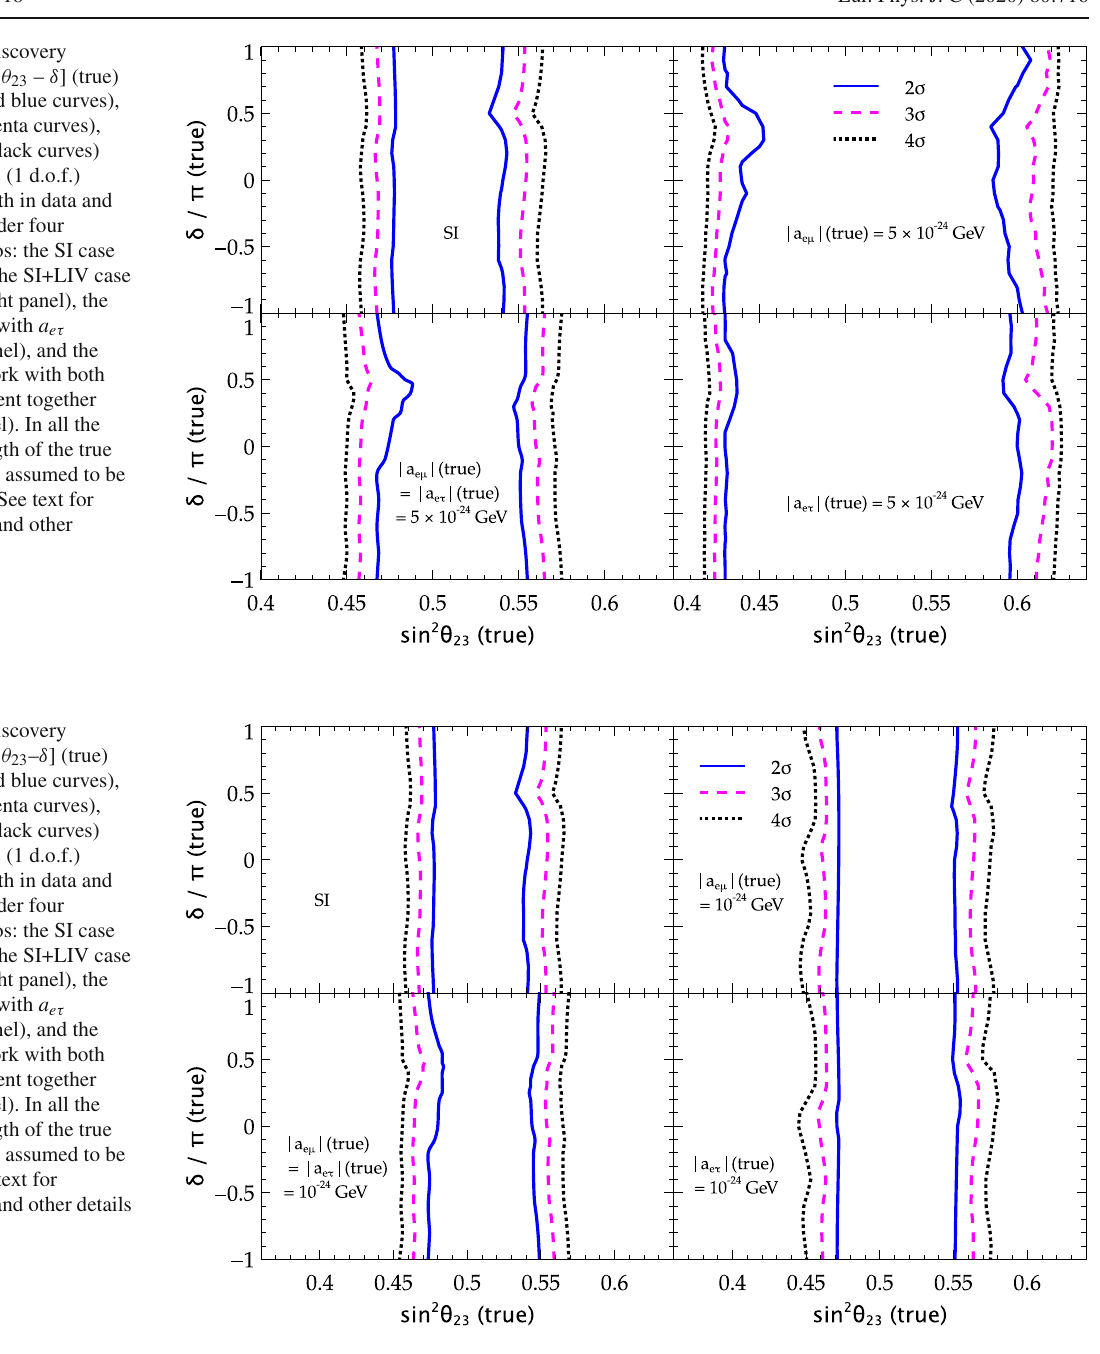
vidual LIV parameter a e μ (top right panel) or a e τ (bottom right panel), the sensitivity towards the octant of θ 23